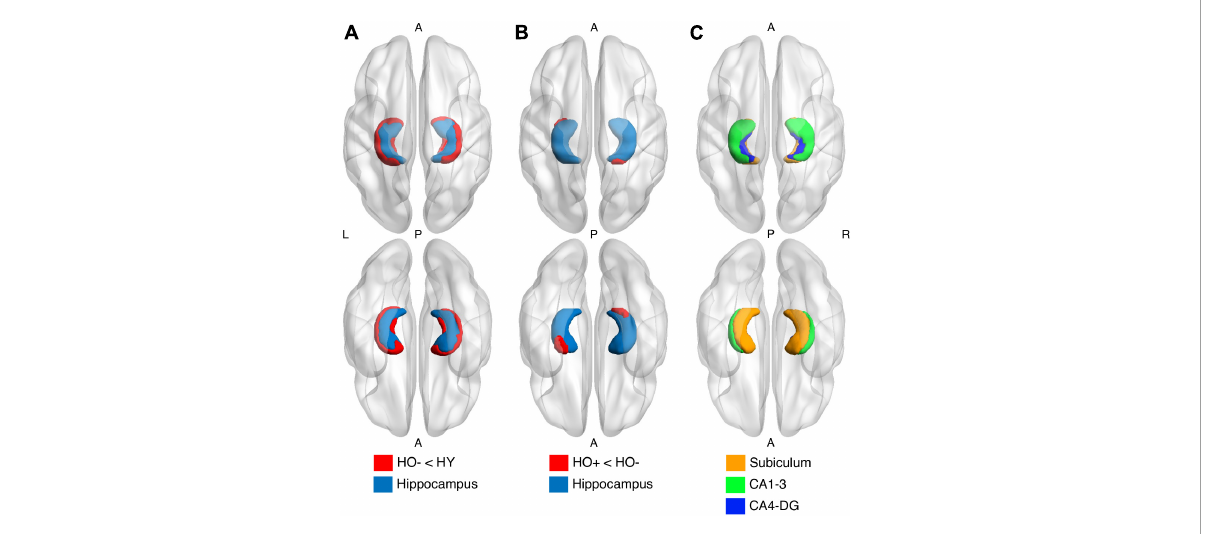
FIGURE2 Shape analysis in the hippocampus (light blue) using FSL FIRST shows group differences between healthy young adults (HY) and healthy older adults with negative CSF biomarker status (HO − ) (A) and between HO − and healthy older adults with positive CSF biomarker status (Ho+) (B) . HO − < HY and Ho+ < HO − (red) were found. P -values were determined using general linear models with age and sex as covariates. The results were corrected using threshold-free cluster enhancement where family-wise error rate was controlled at 0.05. (C) Segmentations of the subiculum (orange), CA1-3 (green) and CA4-DG (blue).